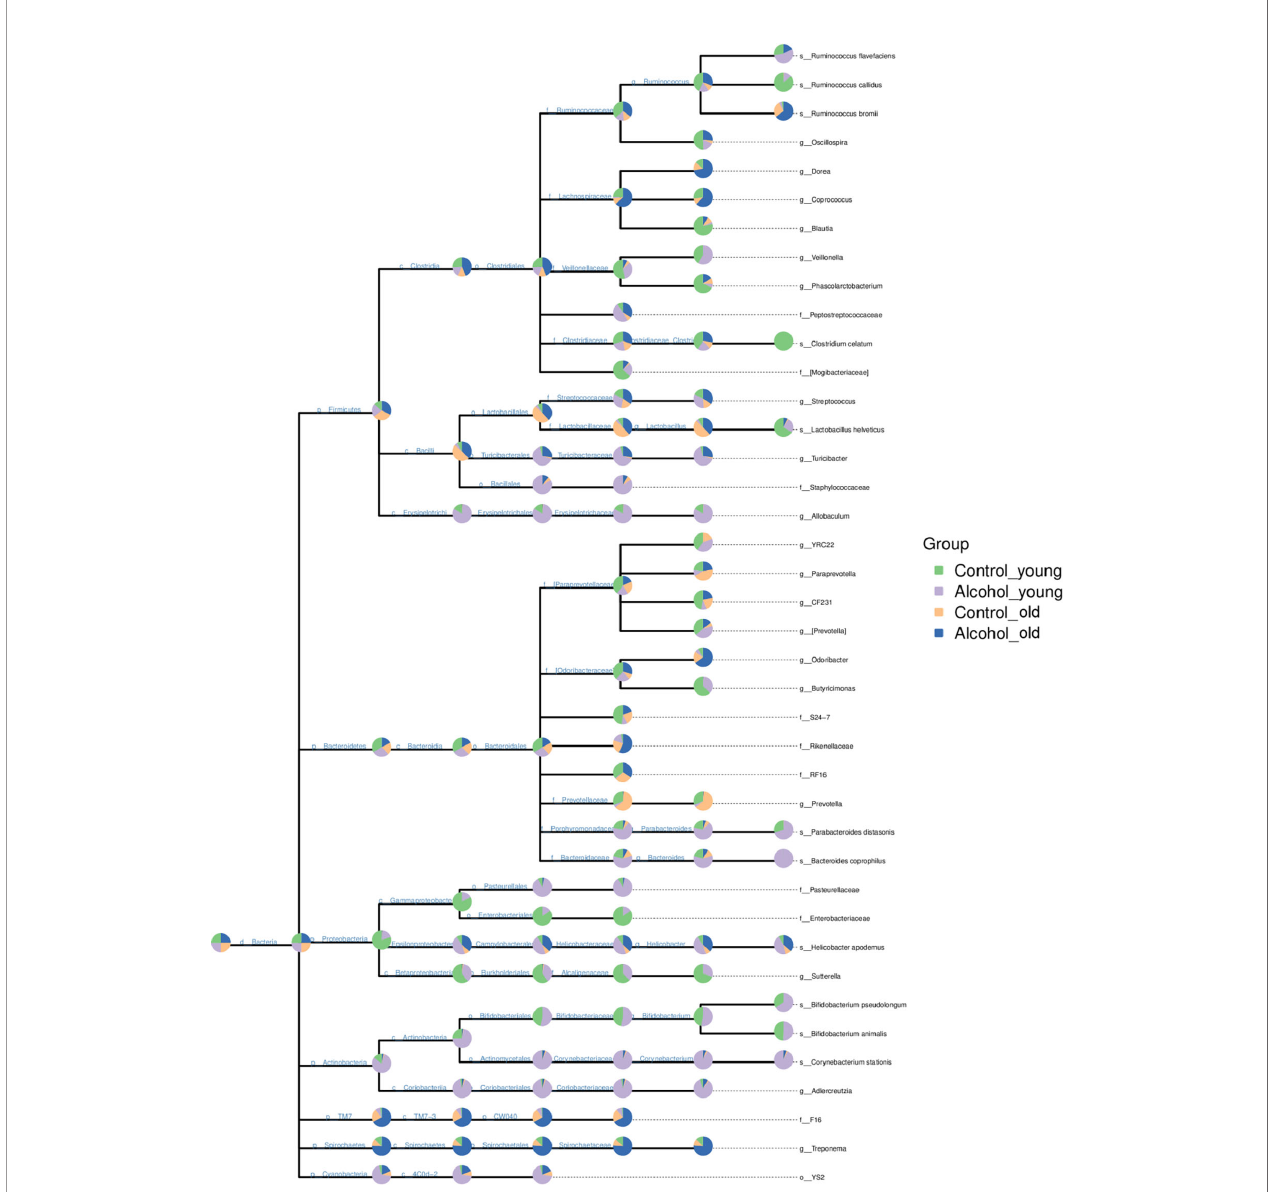
FIGURE 6 | Tree species classi fi cation of young and old rats. The pie chart of different colors represents different groups in that classi fi cation unit. The size of the radius denotes the tag number accounts for the proportion of the total tag; the larger the radius, the higher the abundance. n =